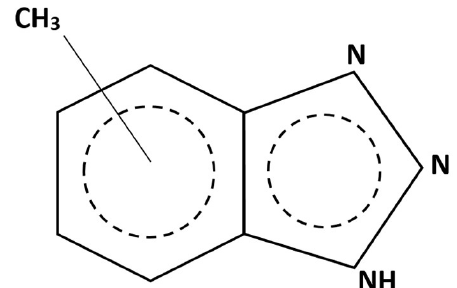
Figure 1. Chemical structure of Tolyltriazole